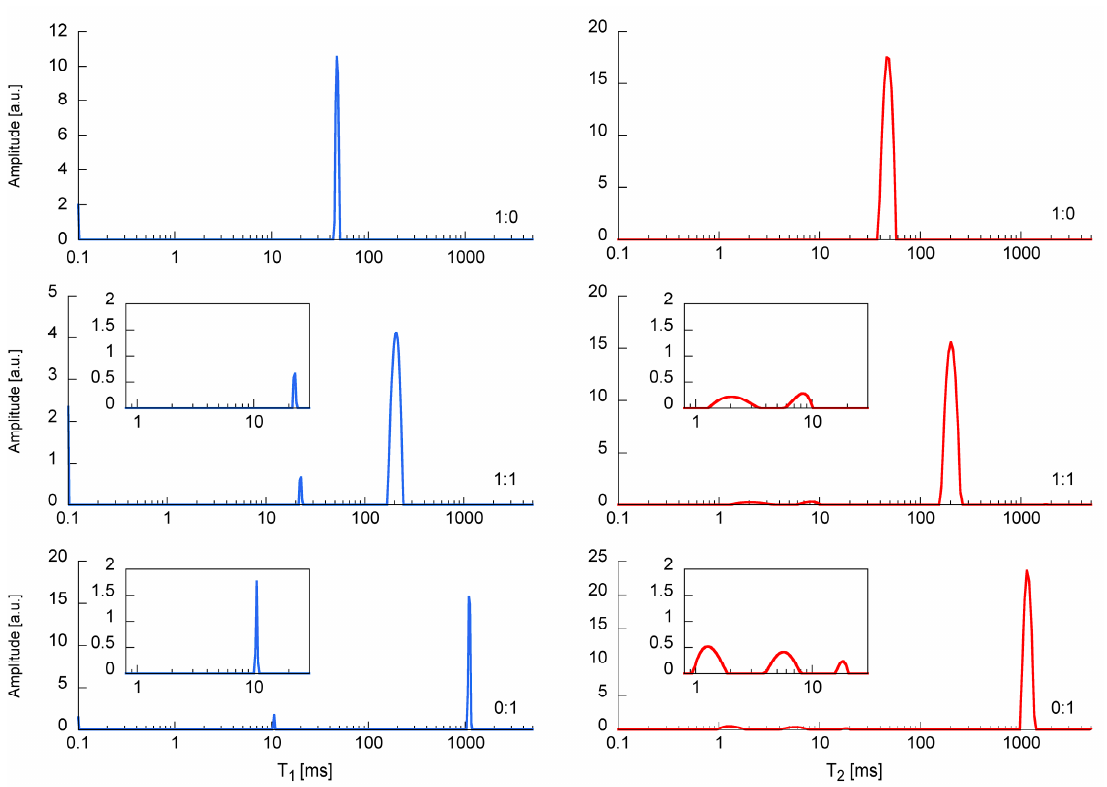
Figure 6. T 1 (left side) and T 2 (right side) relaxation times distributions for the selected samples: sodium water glass R-150 (1:0), polymer-silicate hydrogel of the 1:1 mass ratio (1:1), cross-linked sodium polyacrylate (0:1).